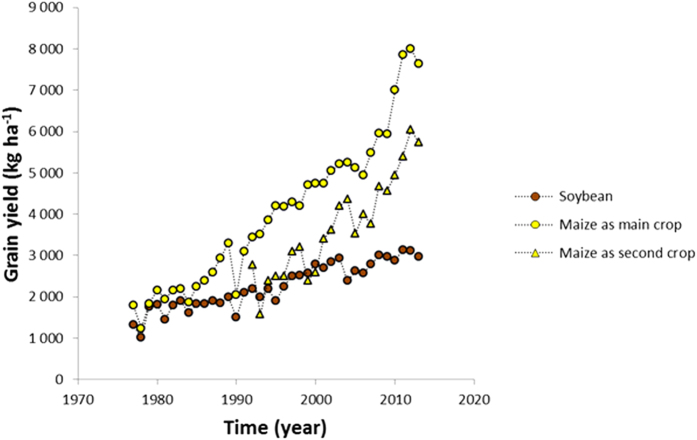
Historical grain yield of soybean and maize (as main or as second crop in the growing season) in the Goiás state, Brazil (data from the Brazilian National Food Supply Agency, www.conab.gov.br).